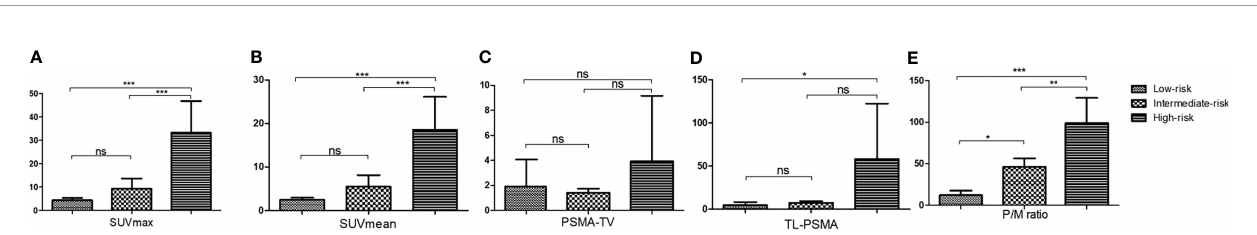
FIGURE 1 | Five common parameters of intraprostatic prostate-speci fi c membrane antigen (PSMA) uptake in newly diagnosed prostate cancer (PCa) patients of different risks. (A) Maximal standardized uptake value (SUVmax), (B) SUVmean, (C) PSMA-TV, (D) TL-PSMA, and (E) prostate/muscle (P/M) ratio were respectively compared between the low-risk group and intermediate-risk group or high-risk group. Each parameter is presented as mean ± SD. NS means no signi fi cance; * means P < 0.05; ** means P < 0.01; *** means P < 0.001.